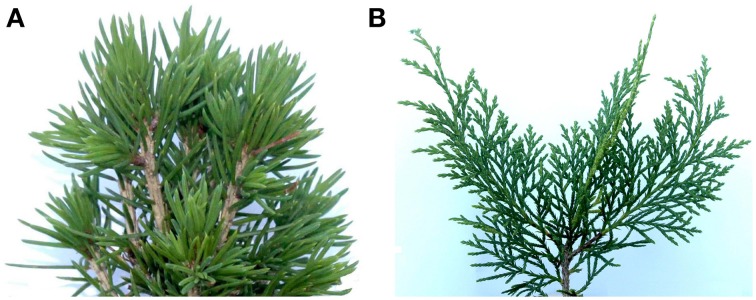
Photographs of a portion of the crown of two of the 15 miniature coniferous trees. (A)
Picea abies Tompa (Norway Spruce) and (B)
Microbiota decussata Gold Spot (Russian Arborvitae), as representative examples of the needlike and scalelike leaf groups, respectively.